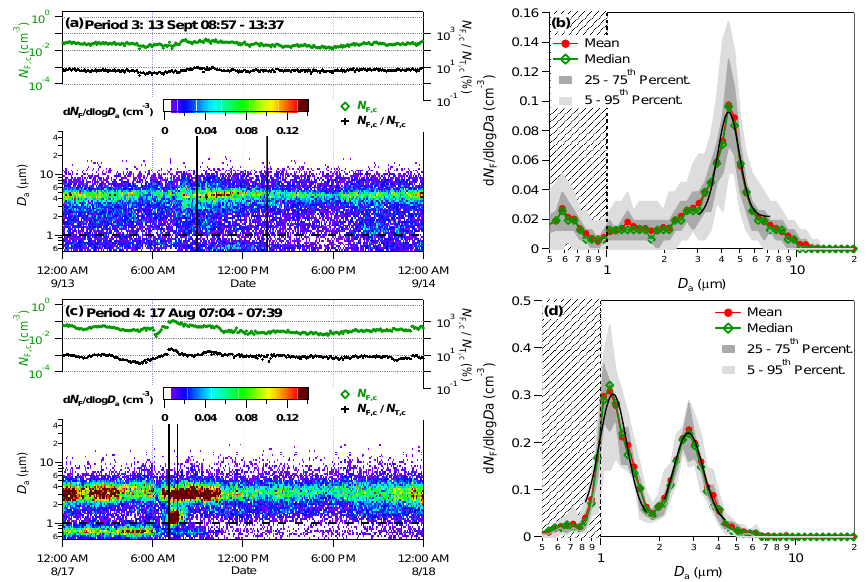
Fig. 8. Characteristic FBAP number size distribution patterns observed during exemplary periods #3 and #4 (plots analogous to Fig. 7). (a)–(b) Period #3; Fit 3.1: D a =3.0–7.2µm; D a , g =4.4µm, σ g =1.14, N =1.0 × 10 − 2 cm − 3 ; (c)–(d) Period #4; Fit 4.1: D a =0.84–1.7µm; D a , g =1.2µm, σ g =1.18, N =4.0 × 10 − 2 cm − 3 ; Fit 4.2: D a =2.1–4.4µm; D a , g =2.8µm, σ g =1.19, N =2.8 × 10 − 2 cm − 3 .